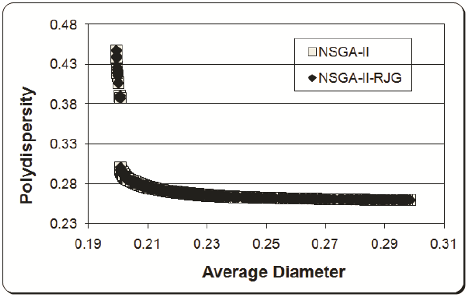
Figure 5. Comparison of the Pareto fronts obtained with NSGA-II and NSGA-II-RJG.